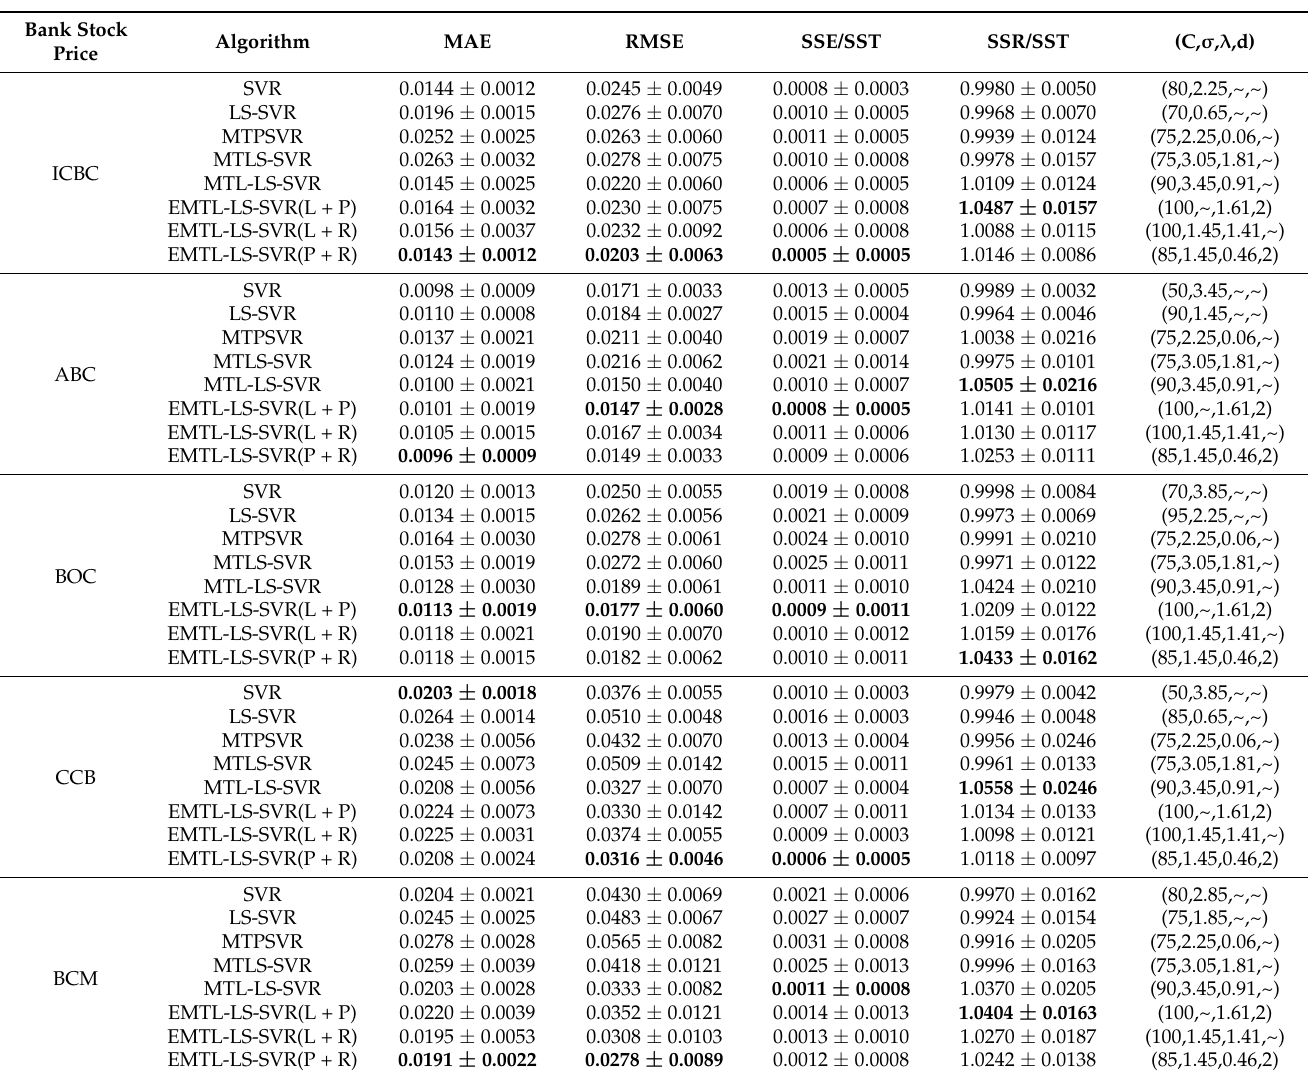
Table 2. Performance comparisons of eight algorithms on stock data of China’s five state